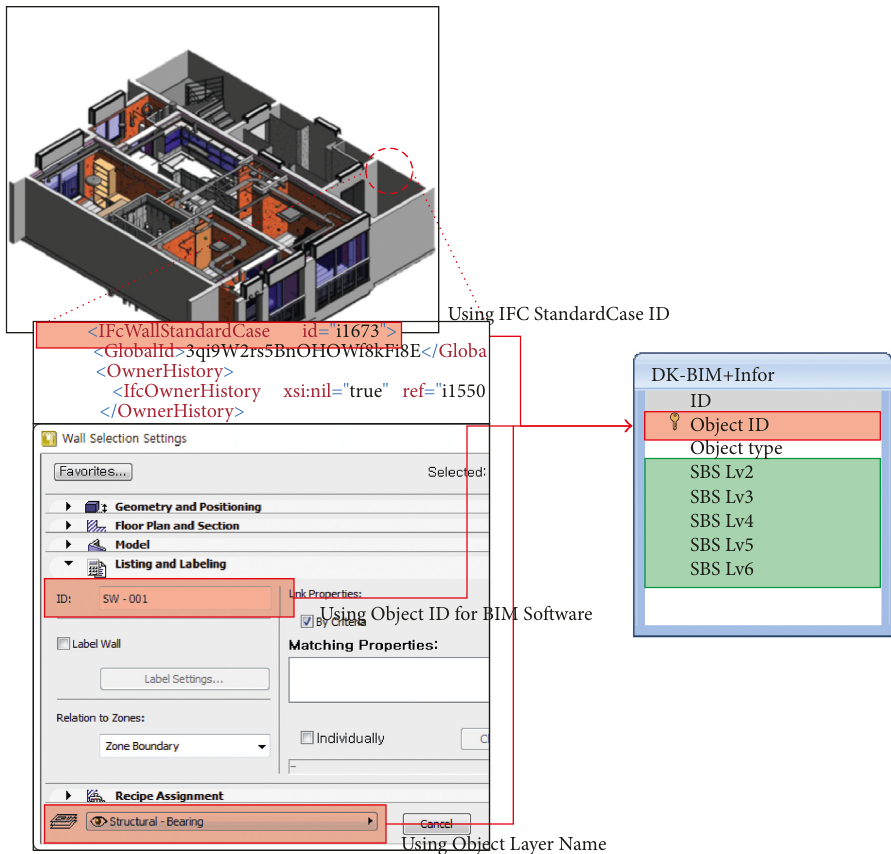
Figure 5: Methods of linking the BIM model with construction